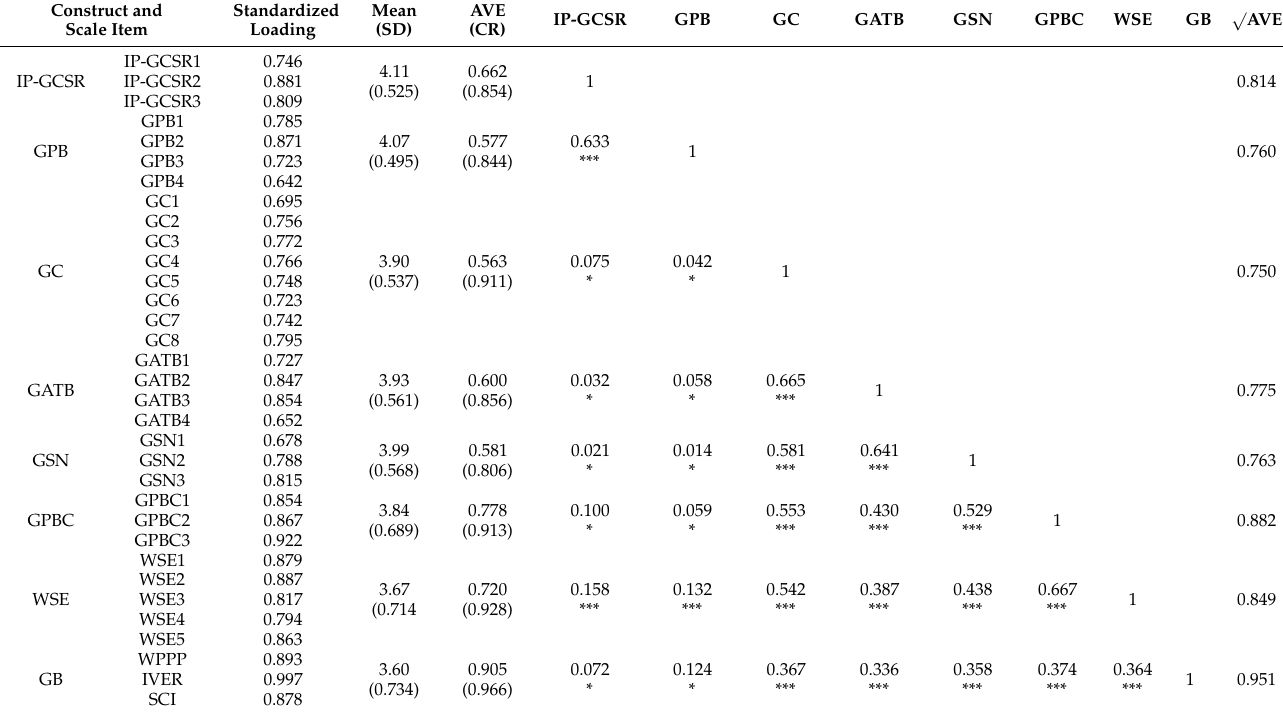
Table 1. The measurement model and